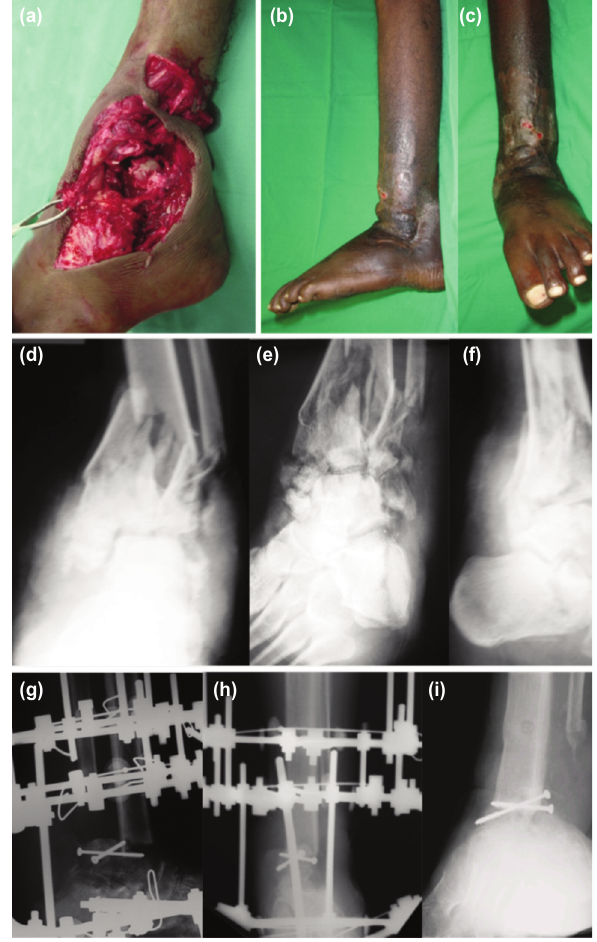
(a) Intra-operative photographs showing comminuted Fig. 3: fracture left ankle. (b,c) Photographs after ankle fusion and removal of Ilizarov. (d,e) Pre-operative radiographs anteroposterior, mortis and lateral views showing comminuted fracture left ankle. (f,g) Immediate post- operative radiographs showing ankle arthrodesis with Ilizarov anteroposterior, lateral views. (h,i) Fifteen months post-operative radiographs showing fusion Ilizarov anteroposterior, lateral